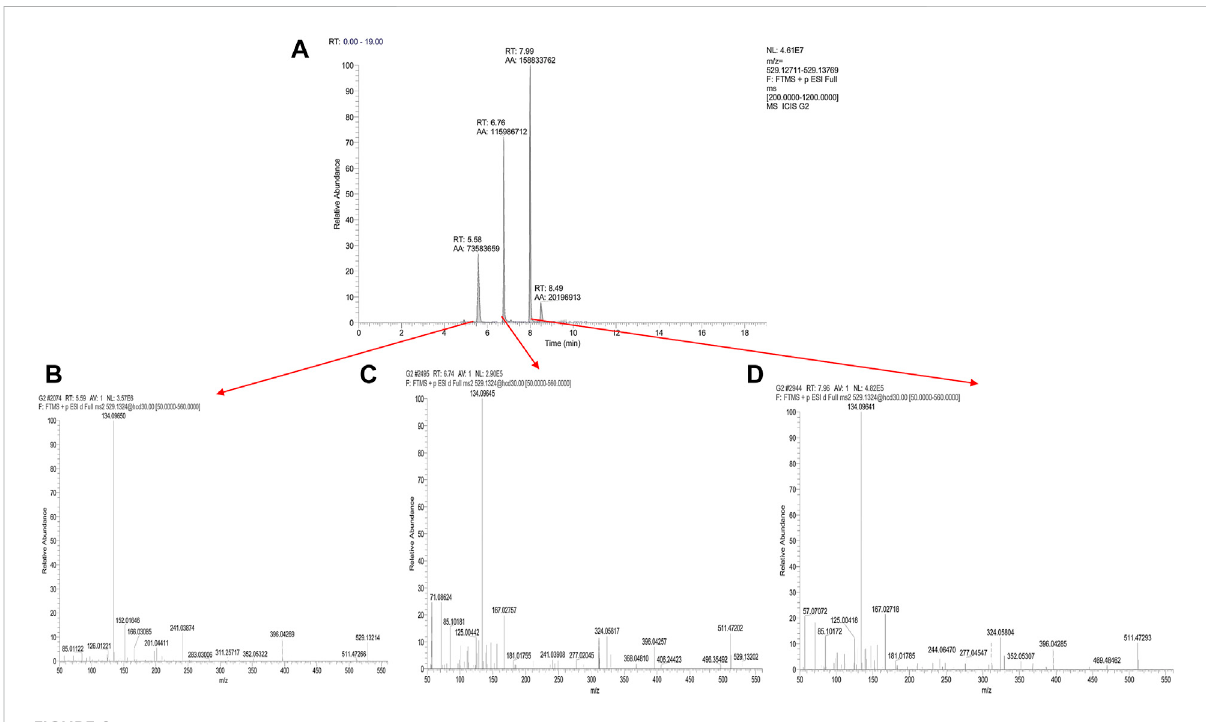
FIGURE 2 ThedegradationpathwayofCEQwasperformedonUPLC-OrbitrapMS(Accurateextractedionchromatograms(EICs)ofmolecularionsof[M+ H] at m/z 529.132 (A) Positive ion ESI-MS/MS spectra of Cefquinome (C) , Δ 3 -isomer of Cefquinome (B) , and E-isomer of Cefquinome (D)